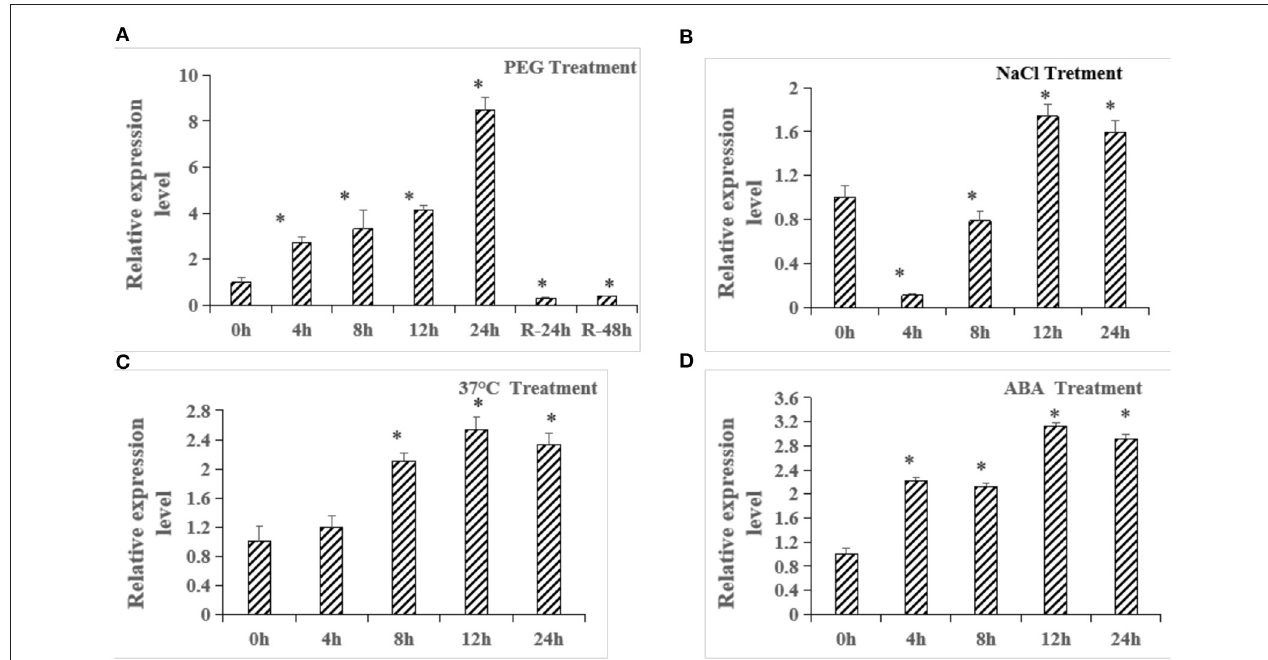
FIGURE 3 | Quantitative RT-PCR analysis of ZmbZIP33 in maize leaves under abiotic stresses and ABA treatment. (A) Relative expression of ZmbZIP33 gene under 20% PEG 6000 treatment at 0, 4, 8, 12, 24h and rewatering at 24h (R-24h) and 48h (R-48h). (B–D) Relative expression of ZmbZIP33 gene under NaCl (200 mmol/L), 37 ◦ C and ABA (5 µ mol/L) treatment at 0, 4, 8, 12, and 24h. Mean values and standard errors (bar) were shown from three independent experiments. Independent t -tests for equality of means demonstrated that there was significant difference between CK and treatment (* P value < 0.05). The followings are the